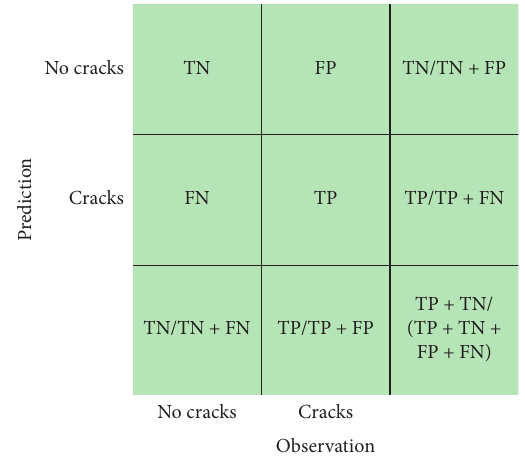
Figure 3: Concept of quality assessment criteria and confusion matrix. Table 2: Parameters during the training